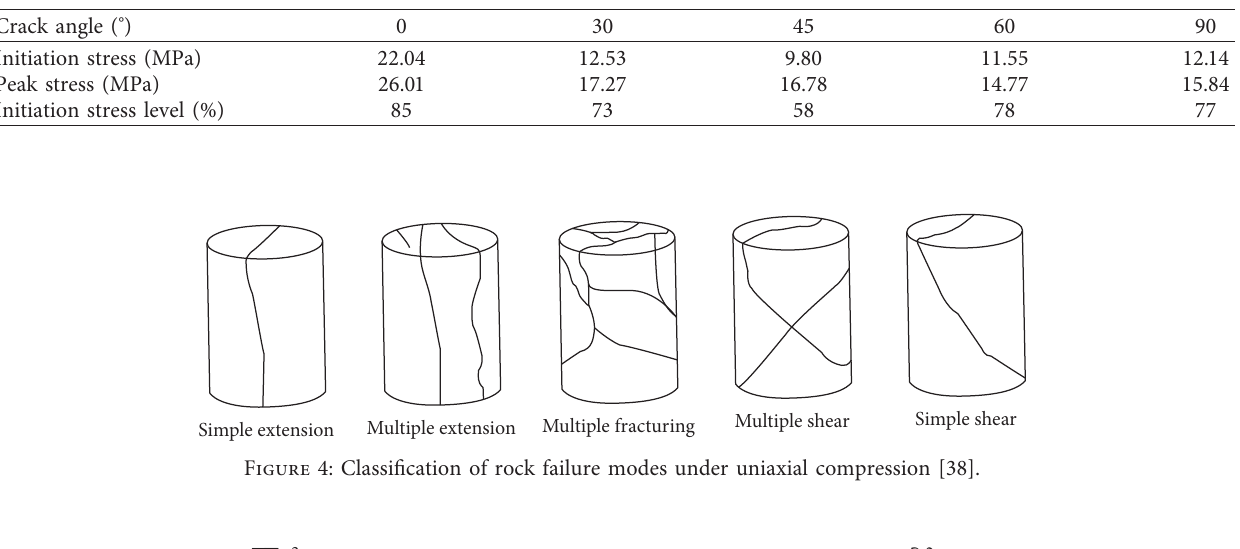
Table 1: Initiation stress and peak stress for different types of samples.